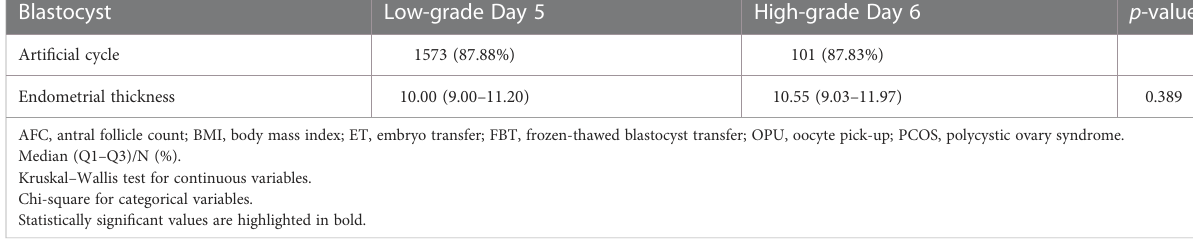
factor has a more signi fi cant effect on the LBR in the multivariable logistic regression model (Table S4), the OR of blastocyst grading (high grade vs. low grade, 1.75, 95% CI 1.53 – 2.01) was greater than